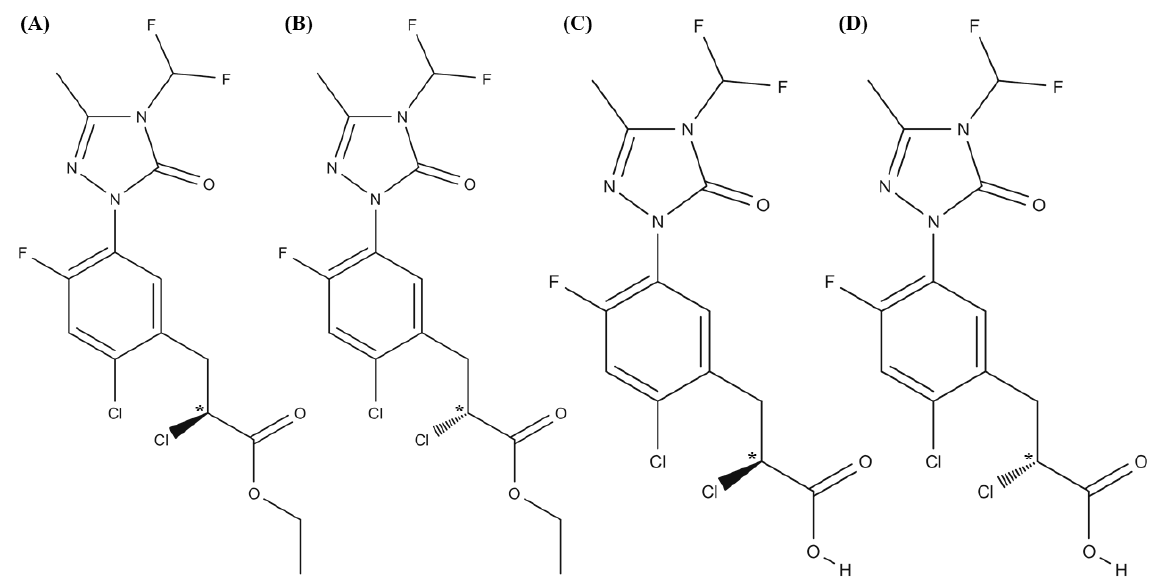
Figure 1. Structures of ( A , B ) carfentrazone-ethyl enantiomers; ( C , D ) carfentrazone enantiomers.